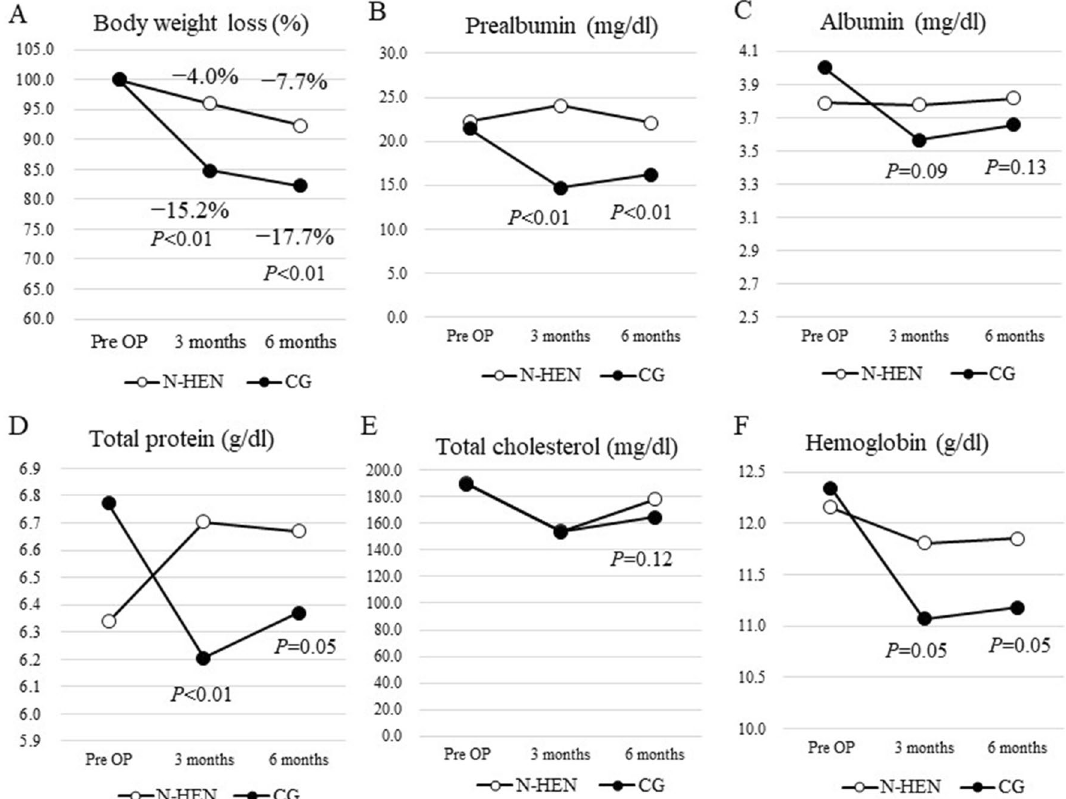
Figure 4. Transition of clinical nutrition parameters. After 3 and 6 months, patients with N-HEN had significantly less body weight loss than CG (3 months P < 0.0001: N-HEN 4.0% vs. CG 15.2%, 6 months P < 0.0001: N-HEN 7.7% vs. CG 17.7%) ( A ). Regarding prealbumin, it was significantly higher in patients with night home enteral nutrition (N-HEN) than the control group (CG) after 3 and 6 months (3 months P < 0.0001: N-HEN 24.1 mg/dl vs. CG 14.7 mg/dl, 6 months P = 0.0037: N-HEN 22.1 mg/dl vs. CG 16.2 mg/dl) ( B ). Also, albumin ( C ), total protein ( D ) and hemoglobin ( F ) tended to be higher in patients with N-HEN than CG after 3 and 6 months, and total cholesterol after 6 months ( E